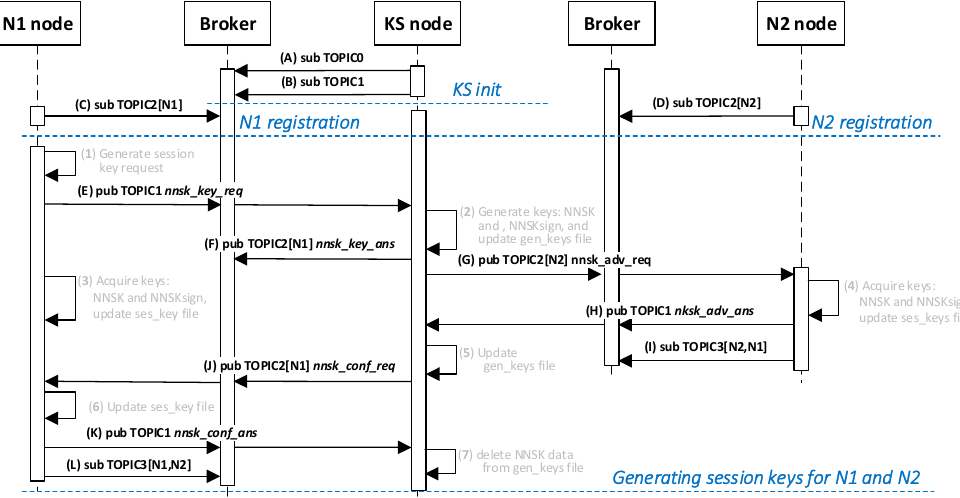
Figure 29. The sequence diagram of the data exchange in the MQTT service for the session key generation procedure.